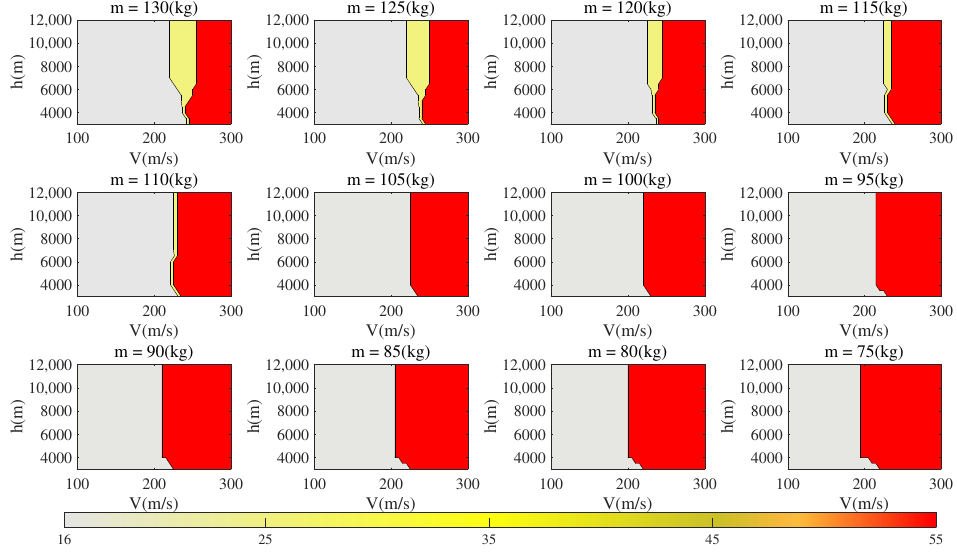
Figure 11. Filled contour plot of the optimal